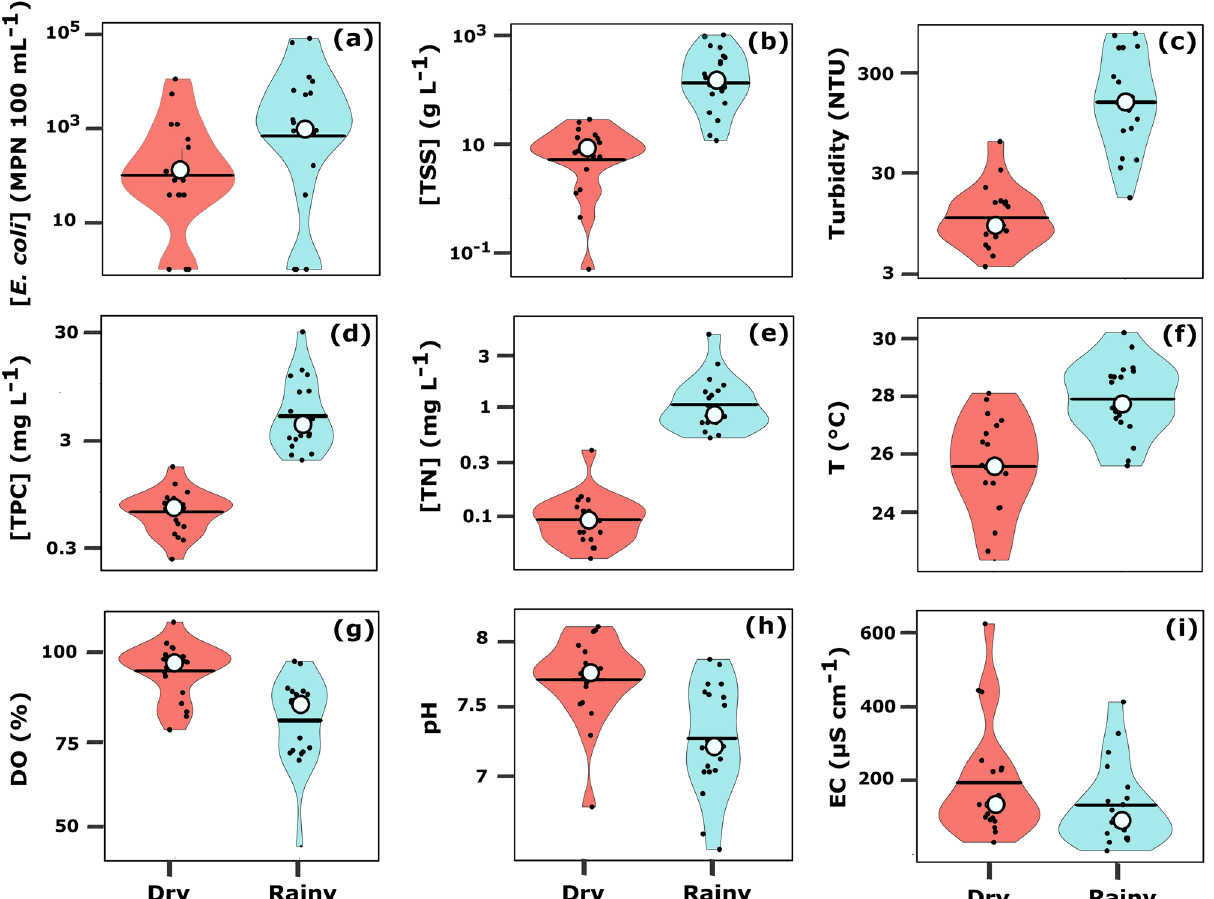
Figure 3. Violin plots of measured variables across sampling sites in Mekong tributaries of Lao PDR in March 2016 (dry season) and in July 2016 (rainy season): ( a ) E. coli concentrations ([ E. coli ], MPN 100 mL −1 ); ( b ) total suspended sediment concentrations ([TSS], g L −1 ); ( c ) turbidity (NTU); ( d ) total nitrogen concentration ([TN], mg L −1 ); ( e ) total particulate carbon concentration ([TPC], mg L −1 ); ( f ) temperature (T, °C); ( g ) dissolved oxygen saturation (DO, %); ( h ) pH; ( i ) electrical conductivity (EC, µS cm −1 ). Black circle represents the mean, the black line is the median, and black dots are the variable observations. Figures generated with RStudio (version 1.2.1335; http://www.r-proje ct.org) and edited with Inkscape (version 0.92.4; https ://inksc to describe the geomorphological features of these catchments (Fig. 4a). To describe the land use within the watershed, we used dams’ reservoir areas (Table S1), and areal percentages of unstocked forest, forest, paddy rice, grassland, urban, water and other agriculture areas in each catchment (Fig. 4b, Table S1), as well as human and livestock population densities per catchment (Fig. 4c,d, Table S1). Furthermore, we used seasonally variable parameters measured during both seasons in 2016, including [TSS], turbidity, [TN], [TPC], T, DO, pH, and EC; as well as the rainfall accumulated over one week before sampling (Fig. 4e,f). During the dry season, [ E. coli ] was mainly explained in the PLS model by the first component (57%) and to a lesser extent by the second component (21.5%) (Fig. 5a, Table S2). The VIPs (Variable Importance in the Projec- tion) for each explanatory variable of both components showed that areal percentages of forest and unstocked forest, [TN], and EC, contributed the most to the model (VIP > 1.5) (Fig. 5c). During the rainy season, [ E. coli ] was mainly explained by the first component (66%) and to a lesser extent by the second component (19%) (Fig. 5c, Table S2). Areal percentages of unstocked forest, turbidity, and [TSS], were highly influential on the model (VIP > 1.5) (Fig. 5d). During both seasons, the first component associated [ E. coli ] with common factors like watershed character- istics including areal percentages of land use classes, population density, catchment area, and physico-chemical parameters ([TSS], [TN], [TPC], and turbidity) (Fig. 5a,b). However, their relative importance changed with the season (Fig. 5c, d). During both seasons, [ E. coli ] was positively correlated to unstocked forest percentage area (r = 0.65 in dry season, r = 0.62 in rainy season, p < 0.05) and negatively correlated to catchment area (r = − 0.49 in dry season, r = − 0.70 in rainy season, p < 0.05). During the dry season, [ E. coli ] was positively correlated with EC (r = 0.59, p < 0.05) and T (r = 0.47, p < 0.05), and negatively correlated with forest percentage area (r = -0.55, p < 0.05) and DO (r = − 0.45, p = 0.054). During